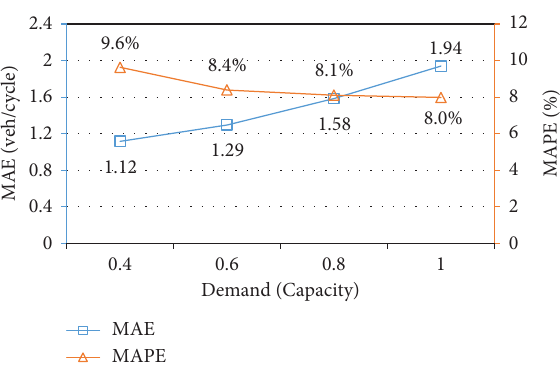
Figure 9: Te overall estimation accuracy under diferent d / c